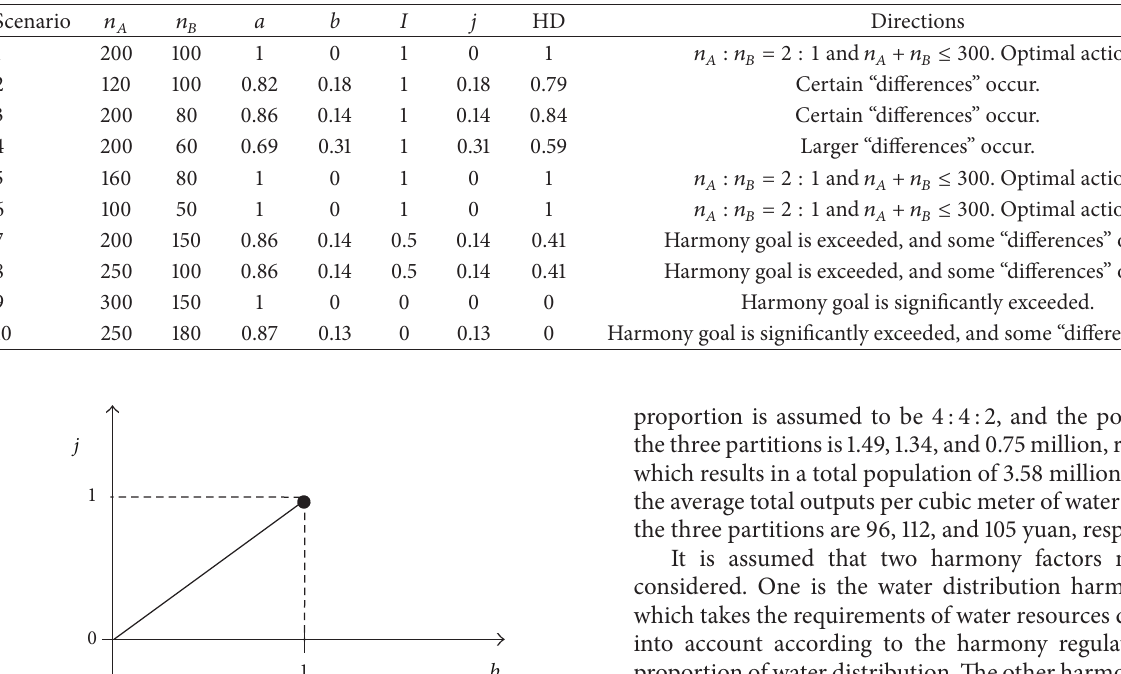
Table 1: Harmony degree calculation for various scenarios of the “tragedy of the commons.”